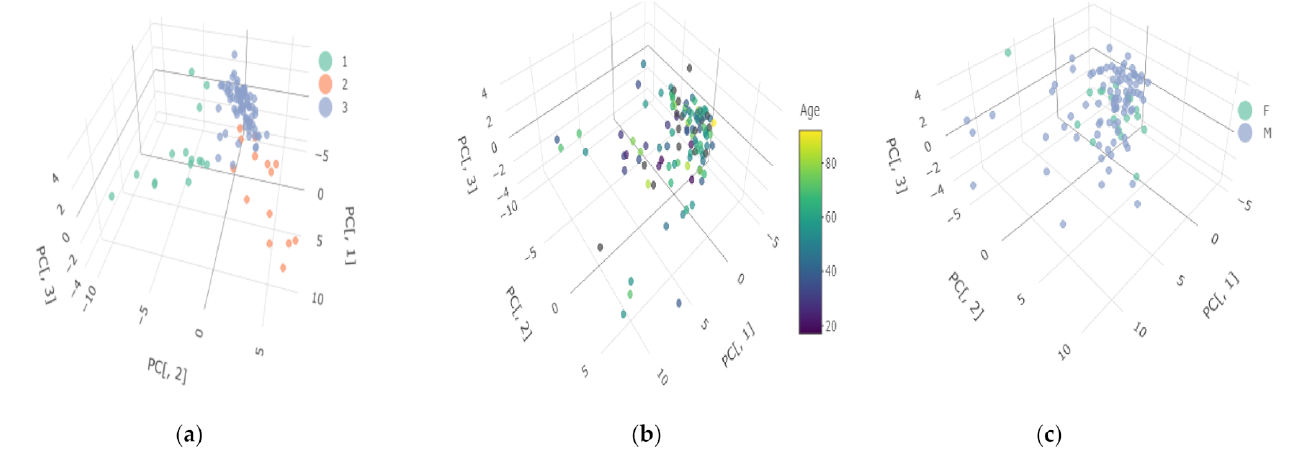
Figure 5. Selected clusters covering all examined subjects ( n = 187) in 3D space: ( a ) 1st cluster— red, 2nd cluster—green; 3rd cluster—blue; ( b ) examined subjects colored depending on the age; ( c ) examined subjects colored depending on the gender according to the attached